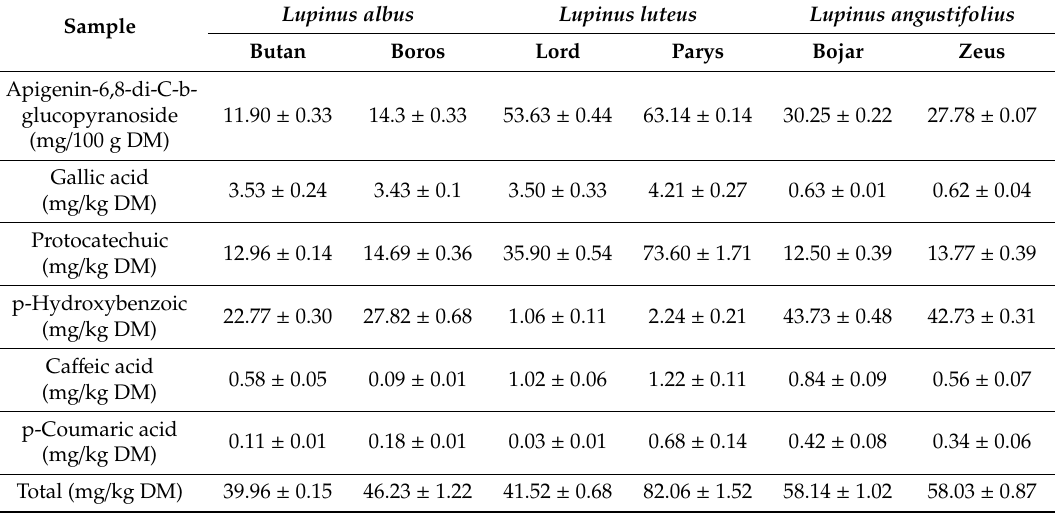
Table 6. Content of phenols and phenolic acids in Lupinus species (mg / kg DW).